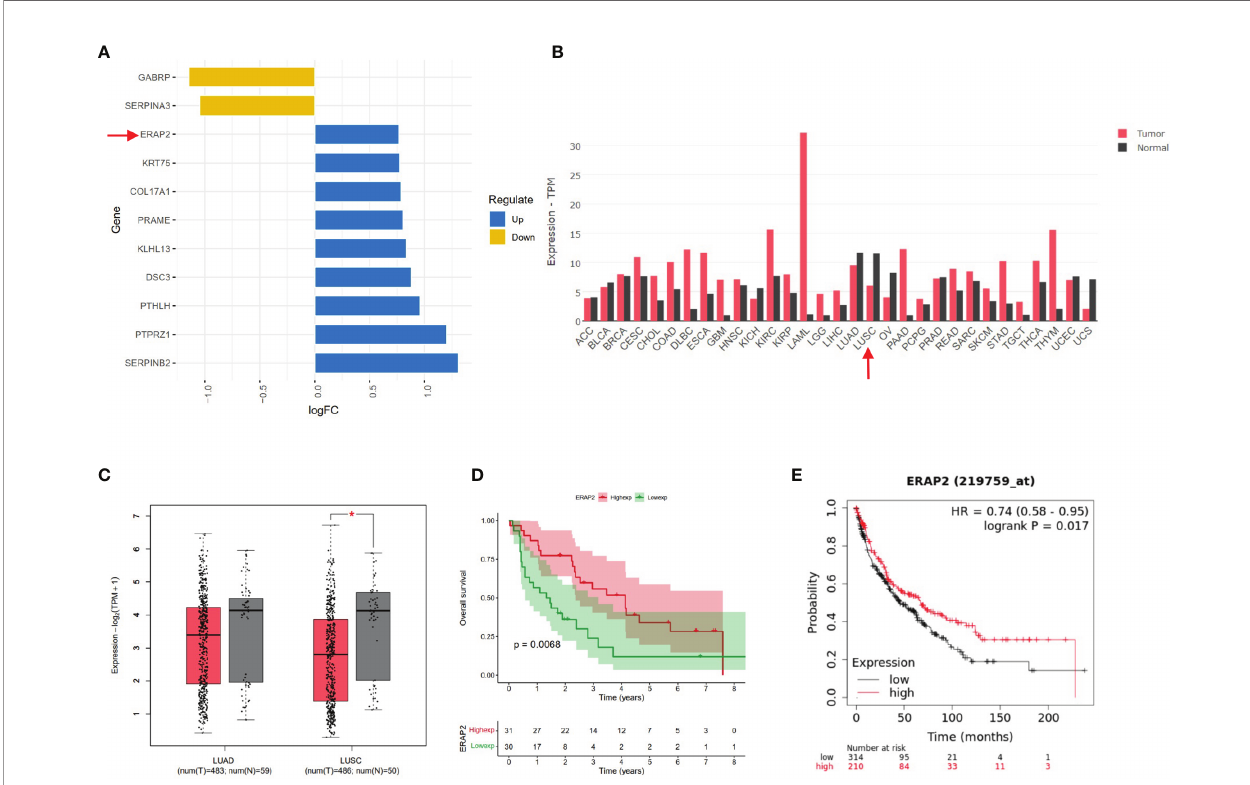
FIGURE 1 | Bioinformatic mining of ERAP2. (A) High and low expression genes of SqCLC patients with better survival based on GEO dataset GSE30219. The length of the bar represents the log (fold change) of gene expression between patients with different survival. Orange, low expression genes in patients with better survival. Blue, high expression genes in patients with longer survival. (B) ERAP2 expression pro fi les across all 31 tumor types and paired normal tissues based on TCGA data. The height of the bar represents the median expression of certain tumor types or normal samples. Red, tumor; Black, normal tissue. Arrow, ERAP2 expression in SqCLC. ACC, Adrenocortical carcinoma; BLCA, Bladder Urothelial Carcinoma; BRCA, Breast invasive carcinoma; CESC, Cervical squamous cell carcinoma and endocervical adenocarcinoma; CHOL, Cholangiocarcinoma; COAD, Colon adenocarcinoma; DLBC, Lymphoid Neoplasm Diffuse Large